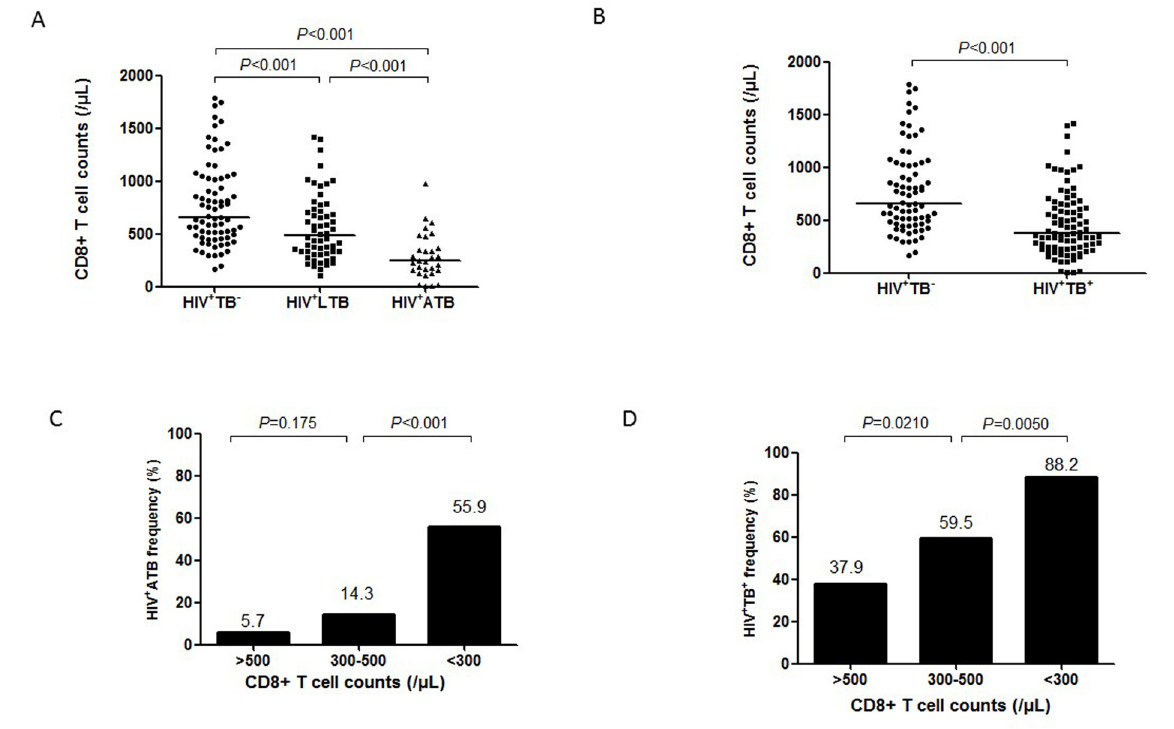
Fig 3. CD8 T-cell counts in HIV-1-infected individuals with different M . tb infection status. A . CD8+ T-cell counts in groups of HIV-1 + TB - , HIV-1 + LTB and HIV-1 + ATB. B . CD8+ T cell counts in HIV-1-infected individuals with or without M . tb co-infection. The horizontal lines represent the median of CD8+ T cell counts in each group. C . and D . Frequencies of active TB (C.) and M . tb co-infection (D.) in HIV-1 + individuals with different CD8+ T-cell counts. Data were analyzed using chi-square test and P values are indicated.